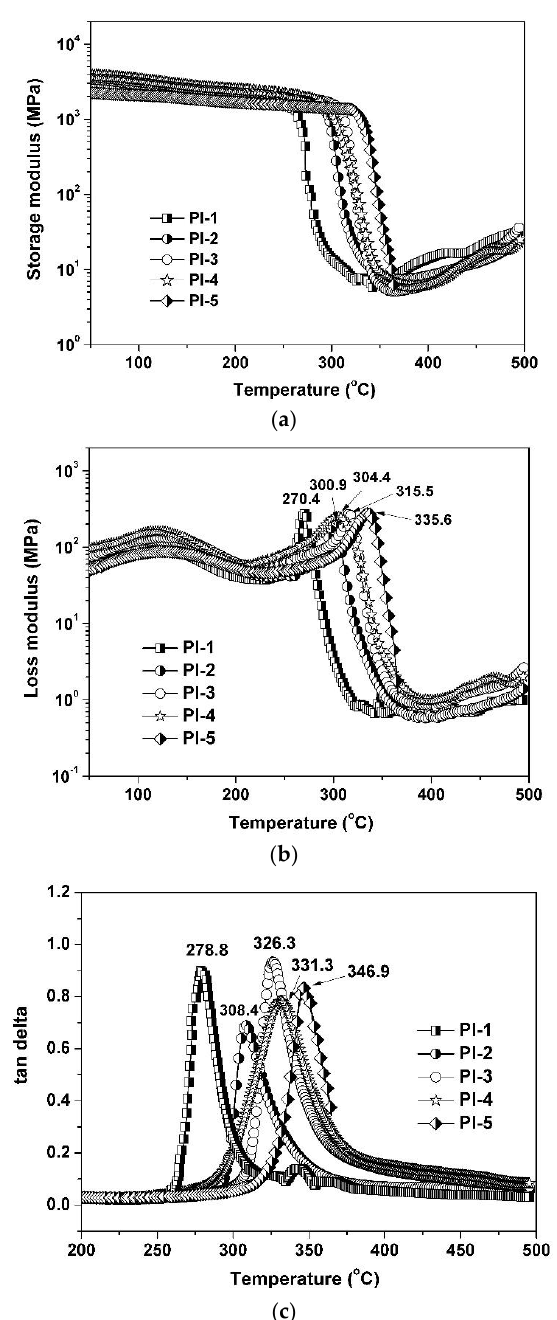
Figure 7. DMA plots of PI coatings: ( a ) storage modulus, ( b ) loss modulus, and ( c ) tan delta.